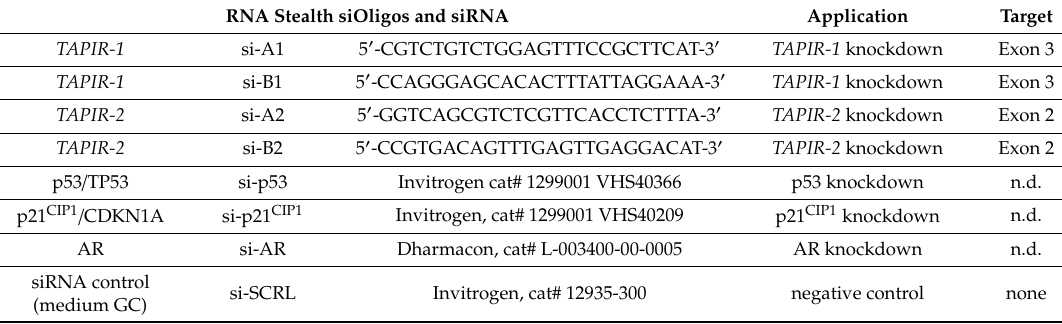
Table 1. List of siRNAs used in the